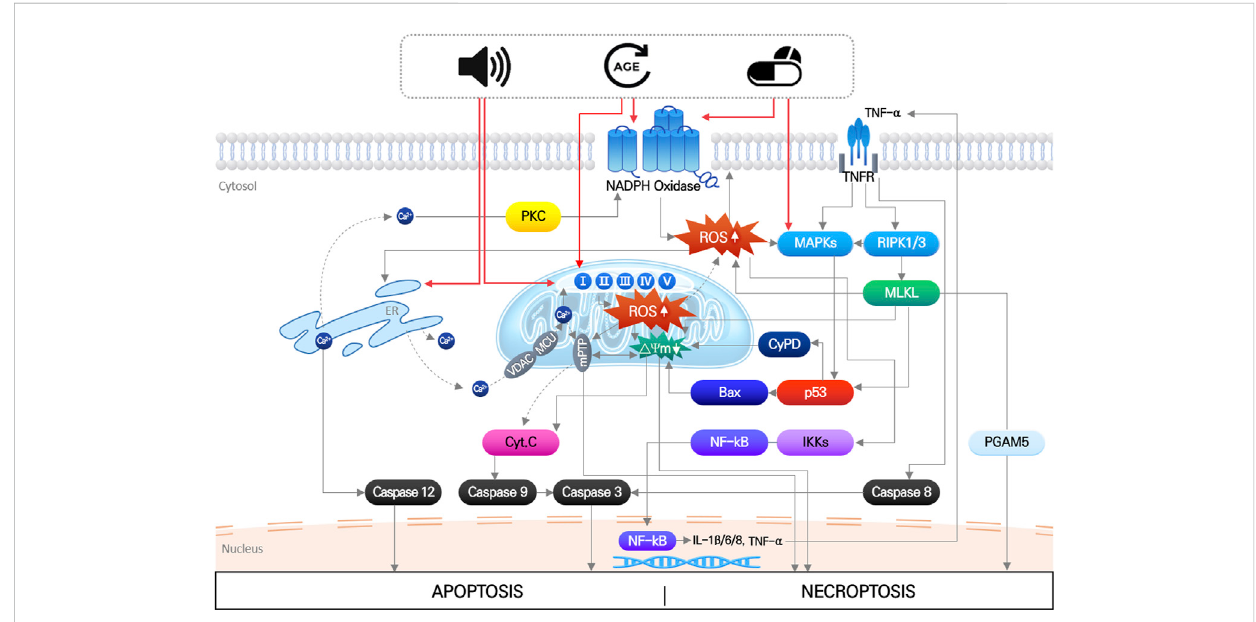
FIGURE 2 Mitochondrial ROS-induced damages causing mitochondrial dysfunction. Direct damages of mitochondrial DNA and antioxidant enzyme, or disruption of ion homeostasis 1), or malfunction of the mitochondrial respiration system 2), can cause increase in mitochondrial ROS. It subsequently leads to increase in mitochondrial membrane potential 3) with depolarization of membrane potential 4), causing osmotic swelling of mitochondria and release of pro-apoptotic factors 5). Finally, cell death signaling pathways are activated by these apoptotic